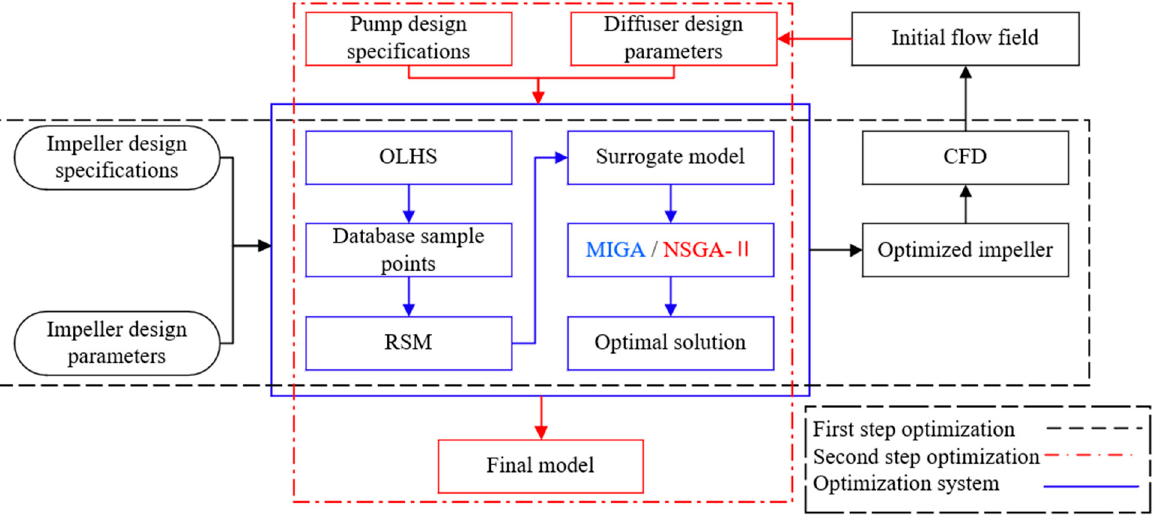
Figure 3. Flowchart of optimization strategy.